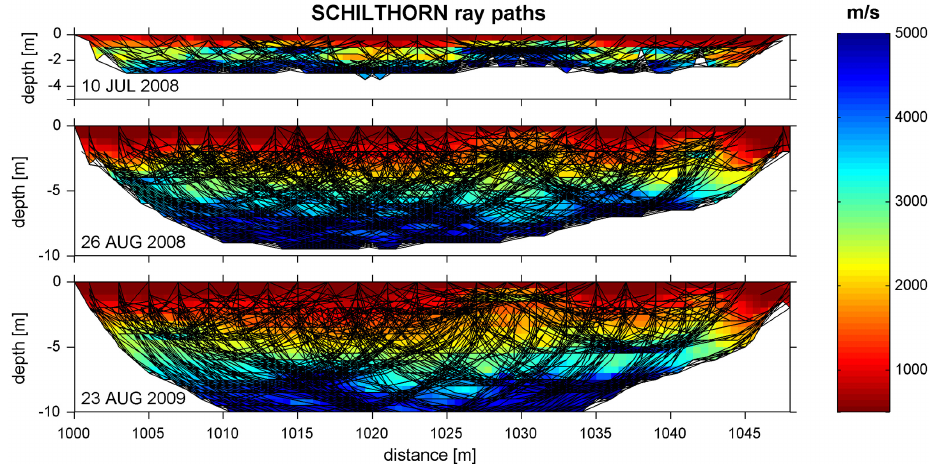
Fig. 13. Calculated ray paths for the tomograms for Schilthorn from 11 July 2008, 26 August 2008, and 23 August 2009. Note that the depth scale is smaller than in Fig.